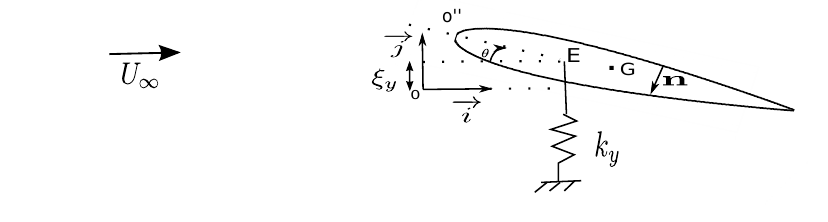
Figure 2. Modeling of the hydrofoil in heave motion with a spring mass